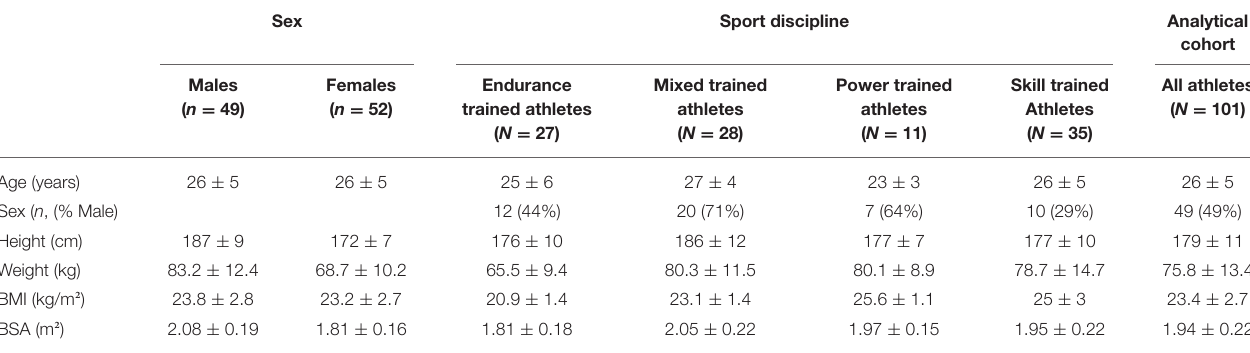
TABLE 1 | Participant characteristics for the whole analytical cohort as well as for groups based on sex and sport disciplines. Sex Sport